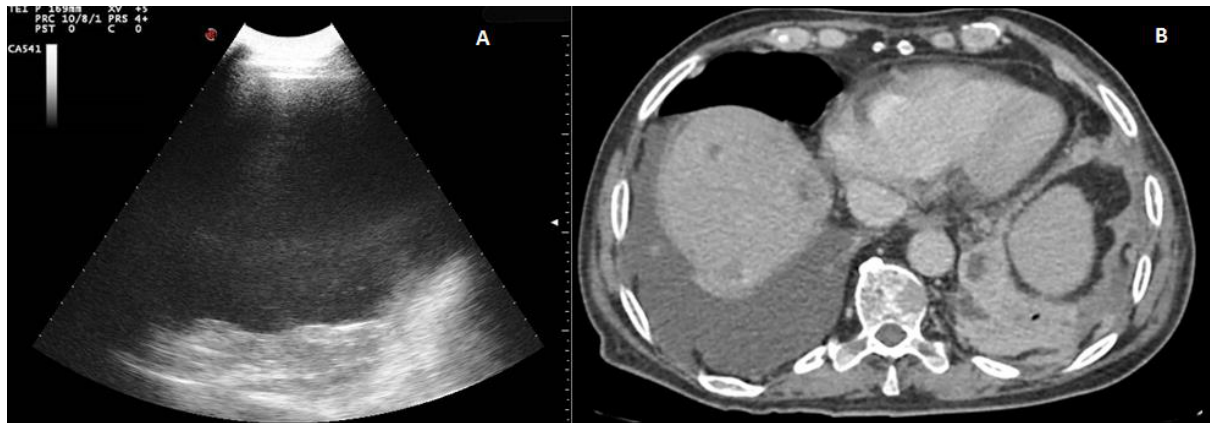
Figure 3. A complex nonseptated pleural exudate in a patient with pneumonia, measured by two orthogonal views (longitudinal and transversal), viewed by longitudinal scan using a convex mul- tifrequency probe (3.5 MHz).